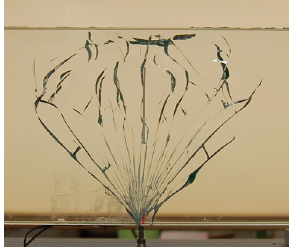
Figure 6: Typical glass fracture Figure 7: Fracture pattern in a more slender composite beam with a pattern in a composite beam. height of 100 mm and loading points in the one-third and two-thirds point of